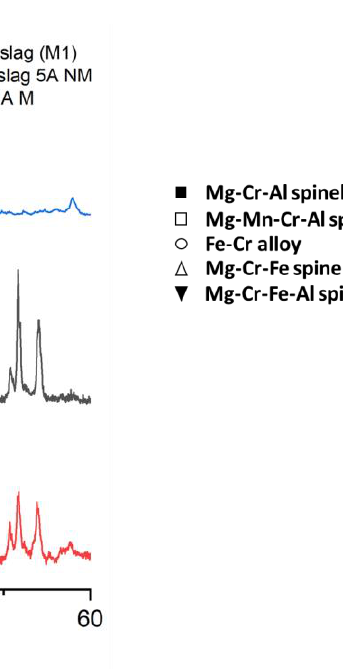
Figure 13. Magnetic properties of different spinel structures [23].